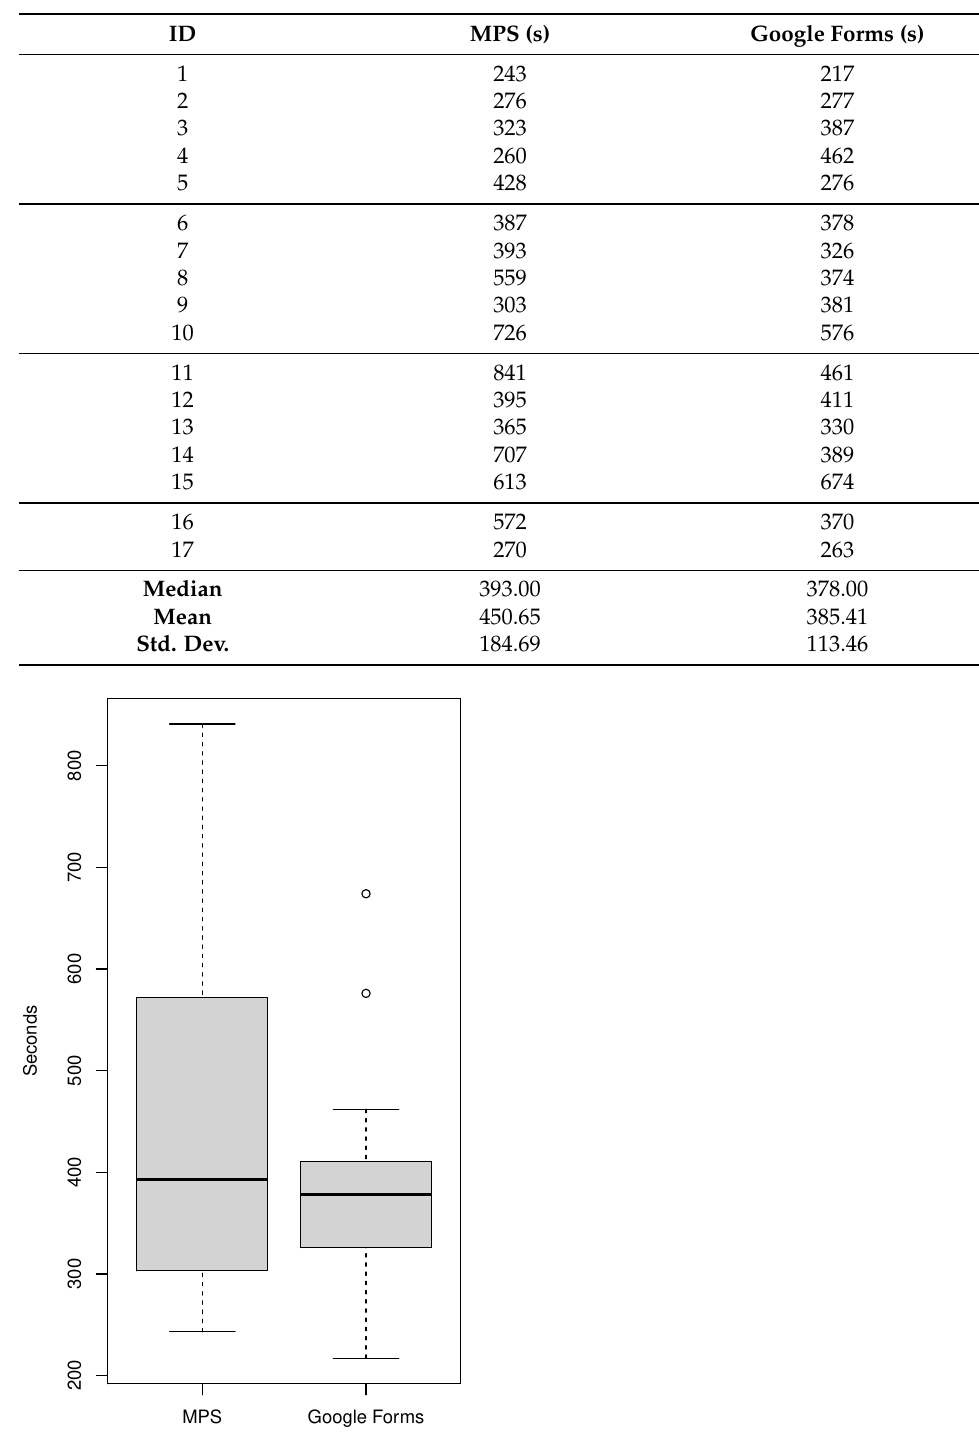
Table 2. Results of the MPS vs. Google Forms experiment.